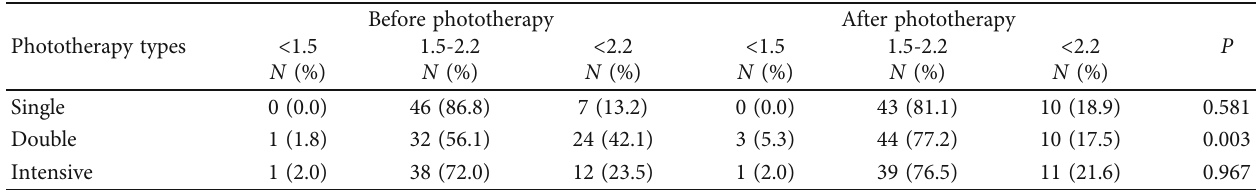
Table 4: Serum magnesium status before and after phototherapy in three treatment groups. Phototherapy